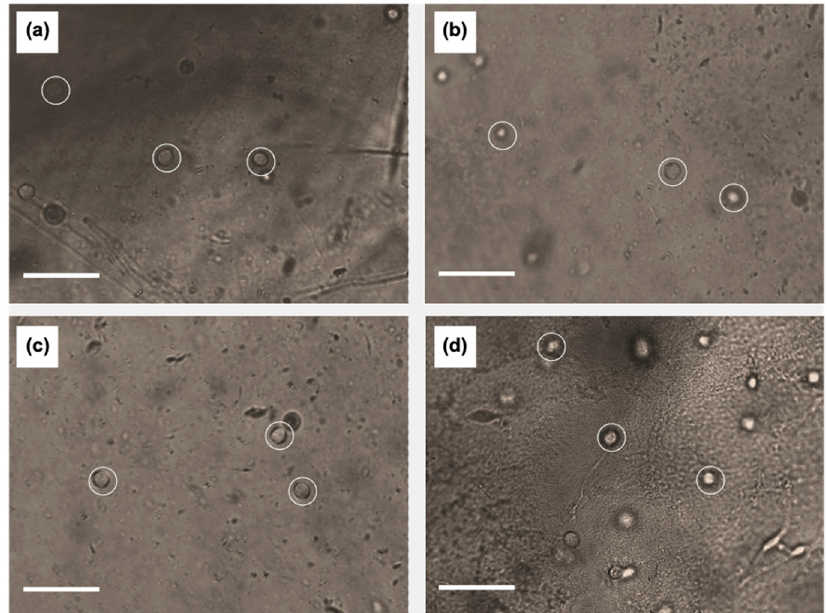
Figure 6. Representative pictures showing migrated U87 cells into RGD-modified alginate scaffolds in the presence of integrin inhibitors ( a ) RGD, ( b ) GRGDSP, and ( c ) cilengitide, and ( d ) unmodified alginate on day 3. The scale bar depicts 100 µm. The images show that cells (representative cells circled in white) did not extend processes in RGD-modified alginate in the presence of integrin inhibitors or in unmodified alginate.